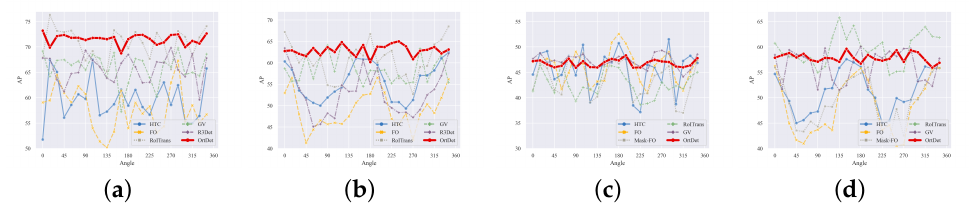
Figure 11. ( a , b ) show the fluctuation of the detection accuracy of the Soccert-ball-field and Basketball- court categories in the DOTA-V1.0 dataset with the rotation angle of the dataset, respectively. ( c , d ) show the fluctuation of the detection accuracy of the Soccert-ball-field category and the Basketball-court category with the rotation angle of the dataset in the DOTA-V1.5 dataset,